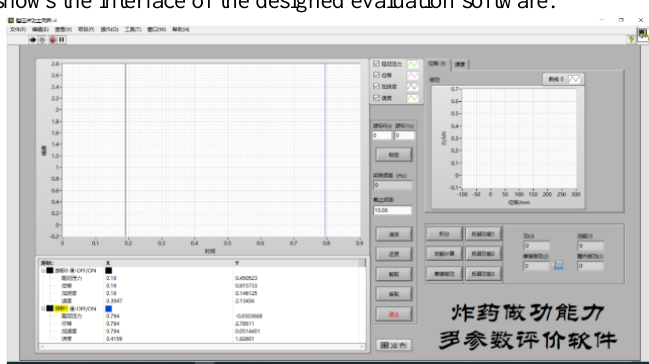
Fig. 7 . Multiparameter evaluation software interface for the function of